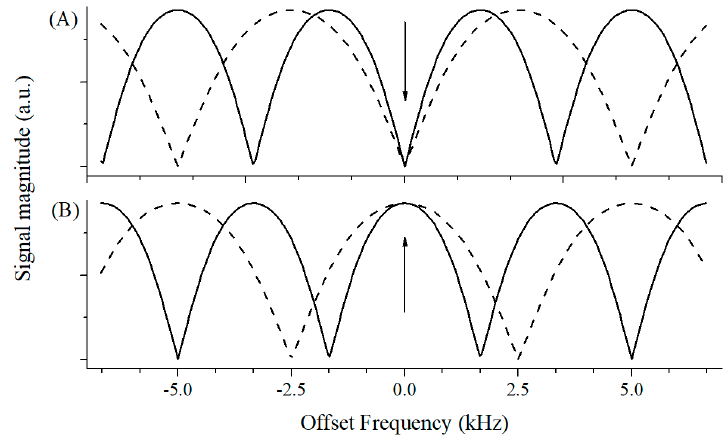
Figure 3. Simulated magnitude profiles of CWFP signals. ( A ) CWFP and CP-CWFP profiles and ( B ) CWFPx-x and CP-CWFPx-x profiles. Solid lines represent the profiles for T p = 300 µ s and dashed lines represented T p = 200 µ s. Adapted from Publication [24], Copyright (2015), with permission from Elsevier.